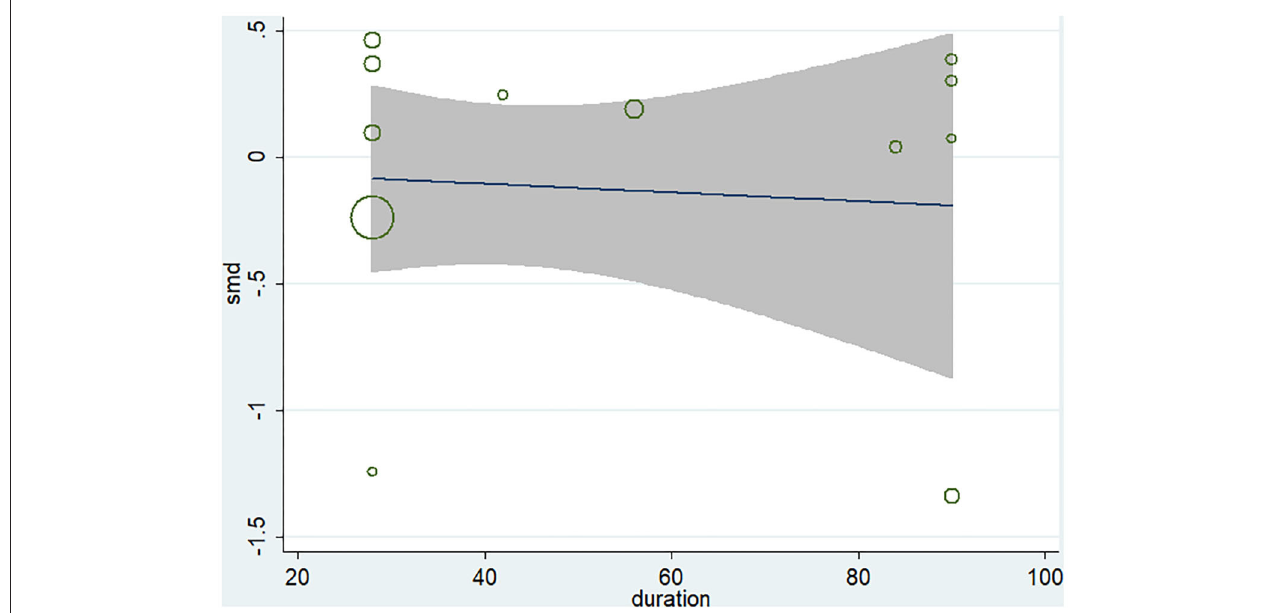
FIGURE 6 | Meta-regression analysis of the influence of intervention time of microbiota-driven therapy on circulating TMAO.